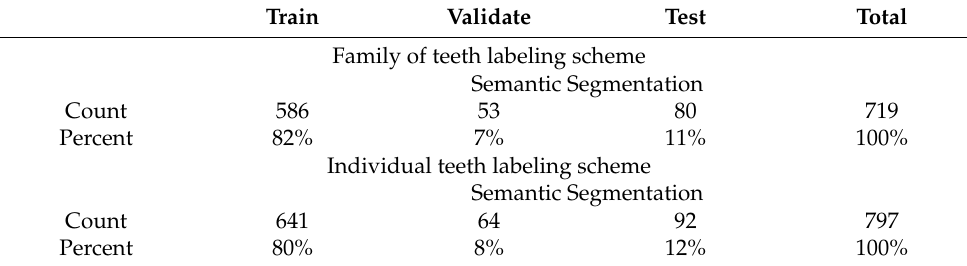
Table 1. The image count and labeling scheme of the original and expanded datasets.